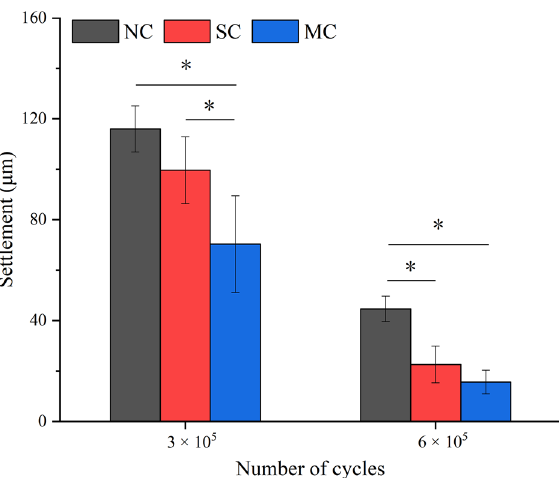
Figure 5. Settlement after cyclic loading in the three groups. *Represents P < 0.05 between